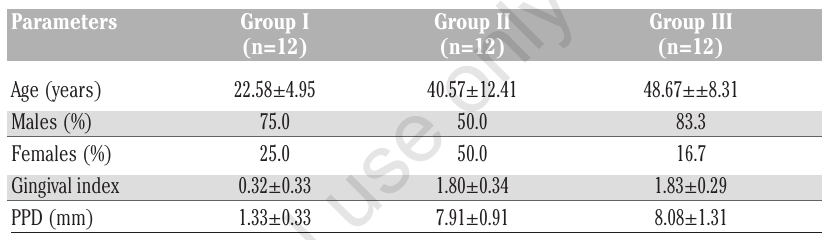
Figure 1. Rapid urease test results of H. pylori before treatment.